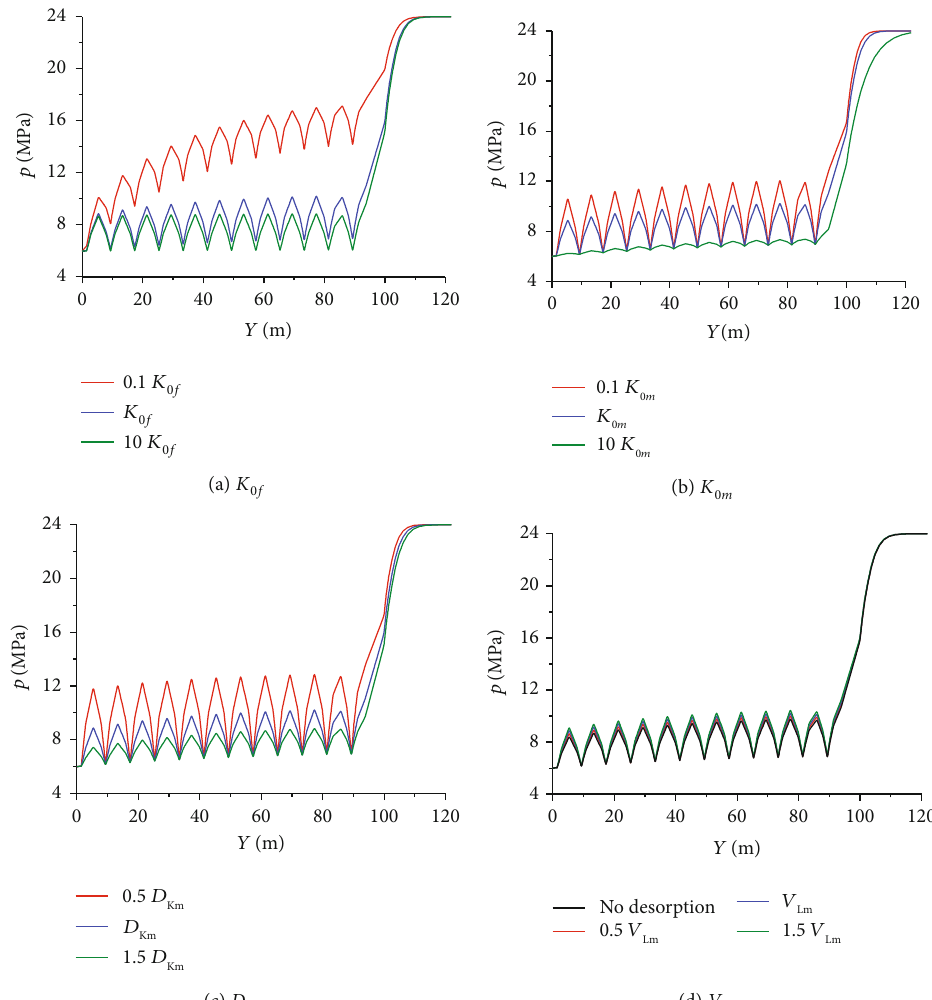
Figure 10: Pressure distribution of parameters with di ff erent values on the cross section x = 4 m after 10 days of development for the lattice- like